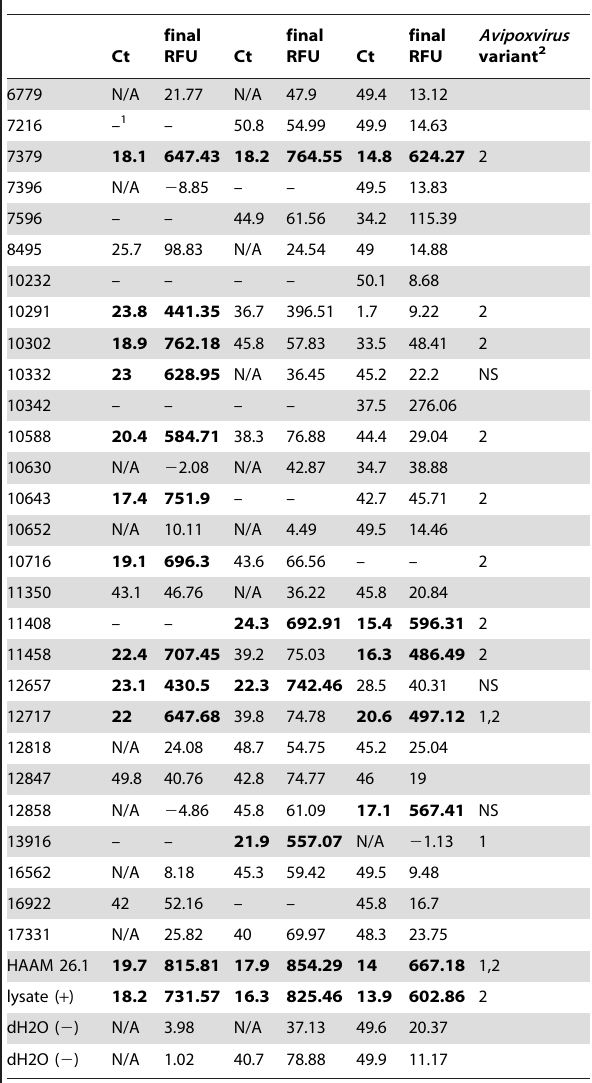
Table 1. Ct values, Ct differences between dilutions, and final intensities for serial dilution of first reaction products from Avipoxvirus culture lysate. Sample dilution